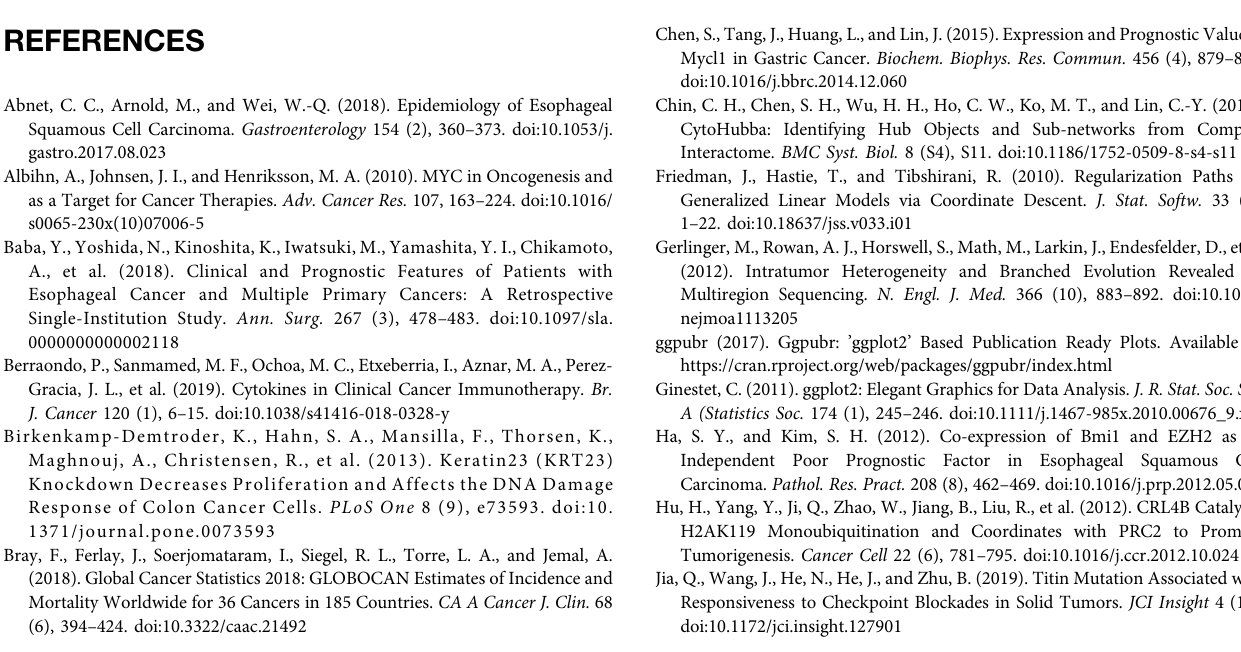
Supplementary Figure S1 | Correlation analysis of SPOCD1 expression and mutation. (A) . The CNV of the group with high expression of SPOCD1; (B) . The CNV of the group with low expression of SPOCD1. SPOCD1, SPOC Domain Containing 1; CNV, copy number variation. Supplementary Figure S2 | Drug sensitivity analysis and drug prediction. (A – D) . The differences in IC50 values for drugs prediction with high and low SPOCD1 expression from the GDSC database. SPOCD1, SPOC Domain Containing 1; GDSC, genomics of drug sensitivity in